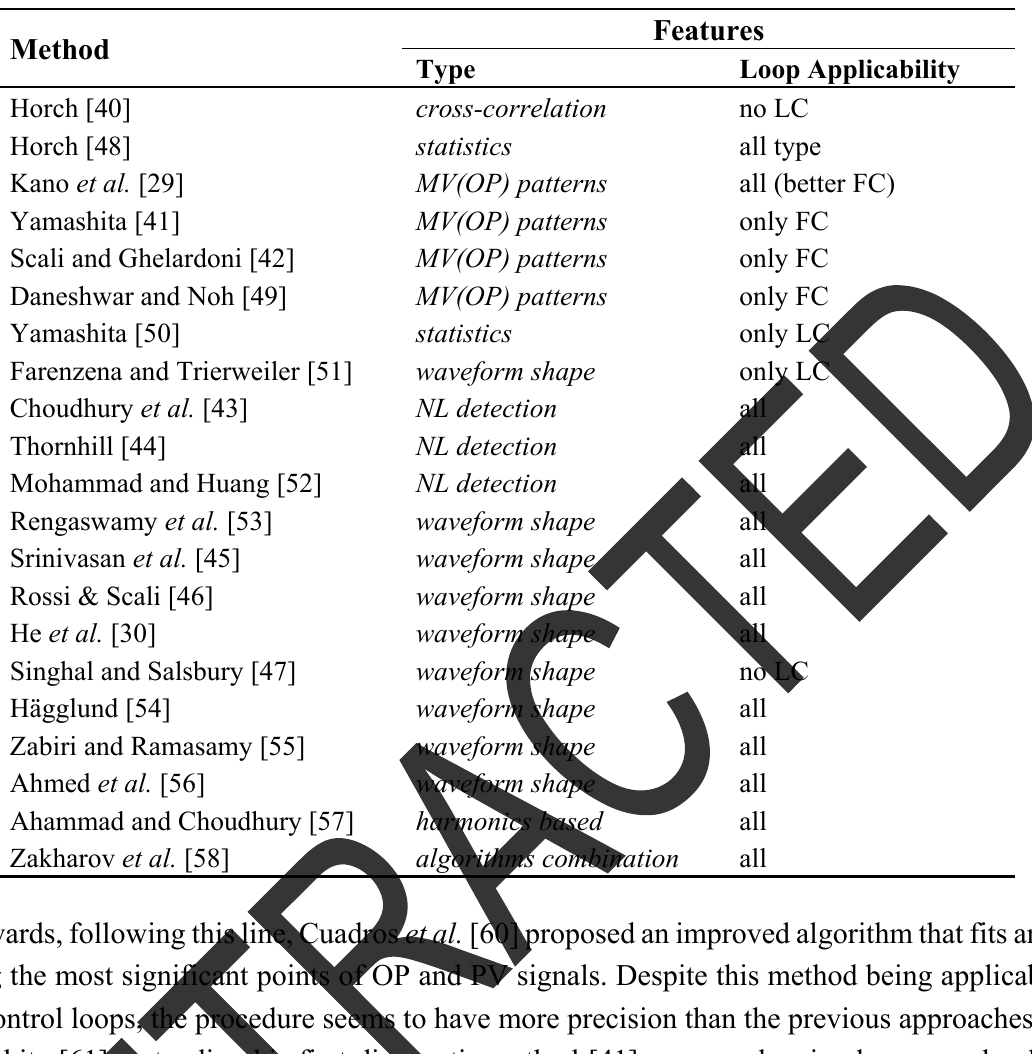
Table 2. Synthesis of stiction detection